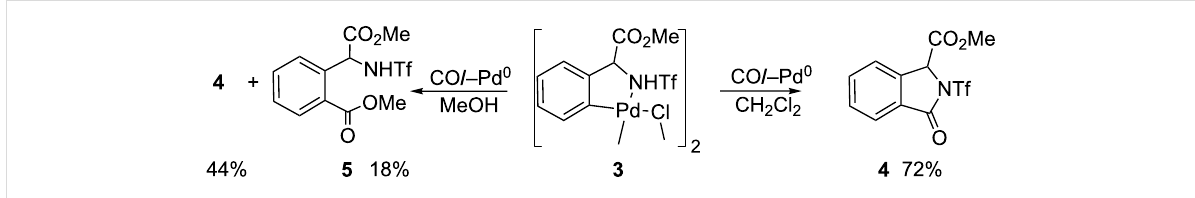
Scheme 5: Reactivity of 3 with CO in the presence (left) and absence (right) of nucleophiles.